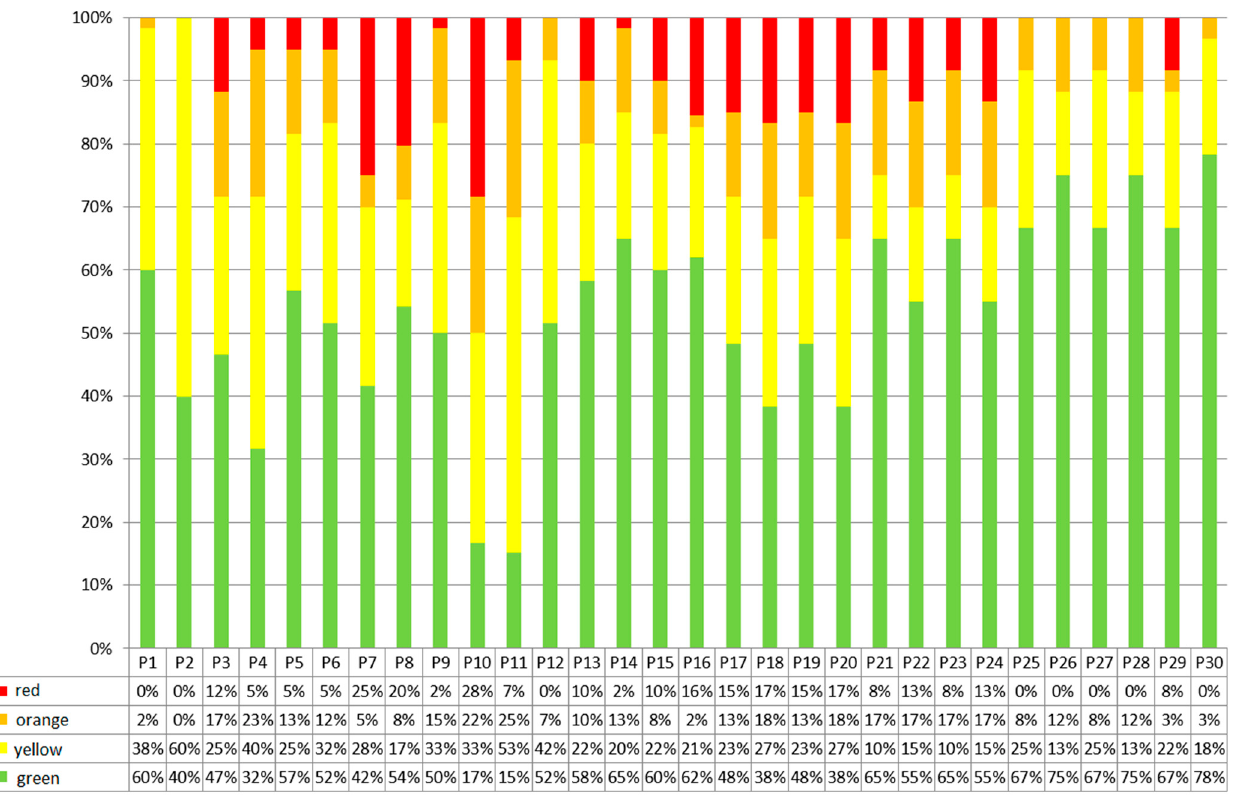
Figure 3. Percentage distribution of results in 4 defined ranges (green, yellow, orange, red) for 30 parameters obtained from patients after stroke—non-dominant upper limb.